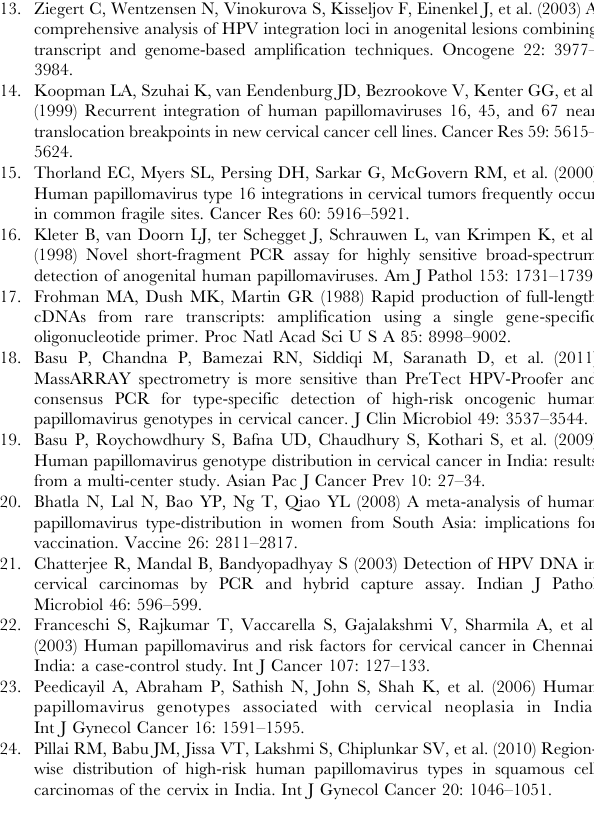
Table S1 Primer sequences. Table S2 Clinicopathological data for all cases where the viral integration was studied. Table S3 Sequence of HPV integration sites in the genome in 68 cases. a) Integration sites for 48 cases with a high prediction score. b) Integration sites for 20 cases with a low prediction